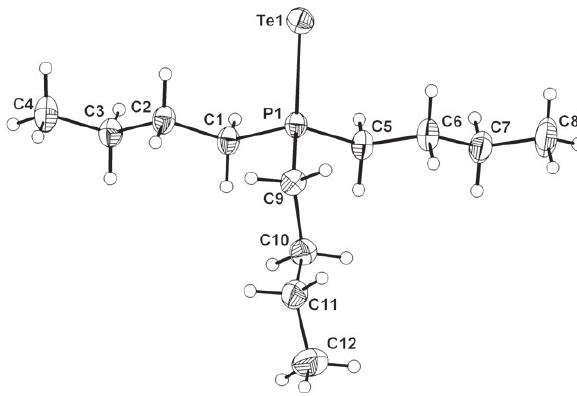
Figure 1 Molecular structure of n -Bu PTe showing 50% probability 3 ellipsoids and the crystallographic numbering scheme. Selected bond parameters ( Å ) are as follows: P1 (cid:2) Te1 2.368 (1), P1 (cid:2) C1 1.817